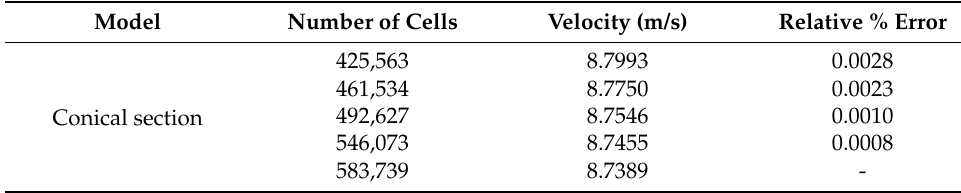
Table 3. Grid independence test